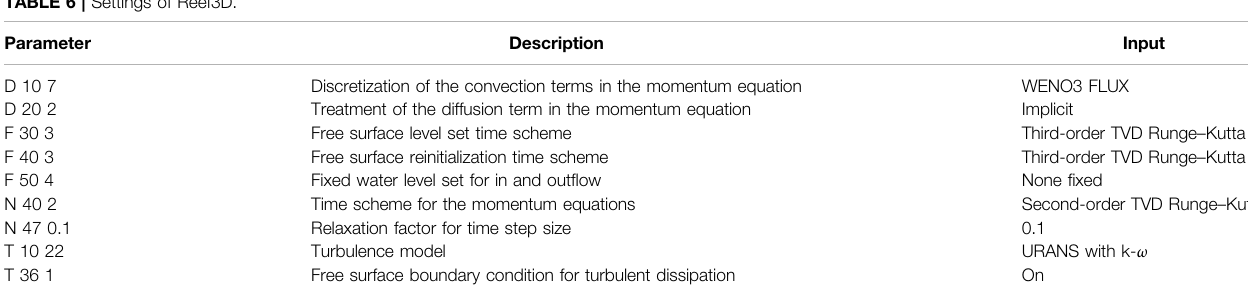
TABLE 6 | Settings of